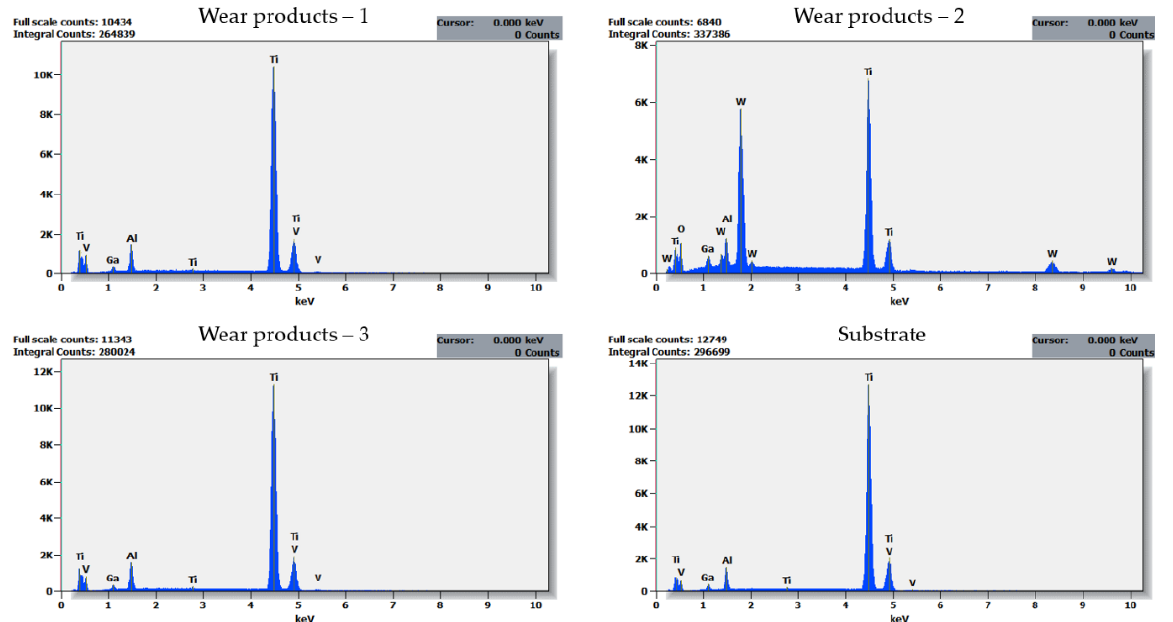
Figure 17. EDX spectra of areas: 1 – 3 identified on a cross-section of Ti6Al4V wear track presented in Figure 16A. The cross-section was obtained with the use of FIB. Therefore, Ga is present in all spectra. For comparison purposes, spectrum of a pure substrate material was added.